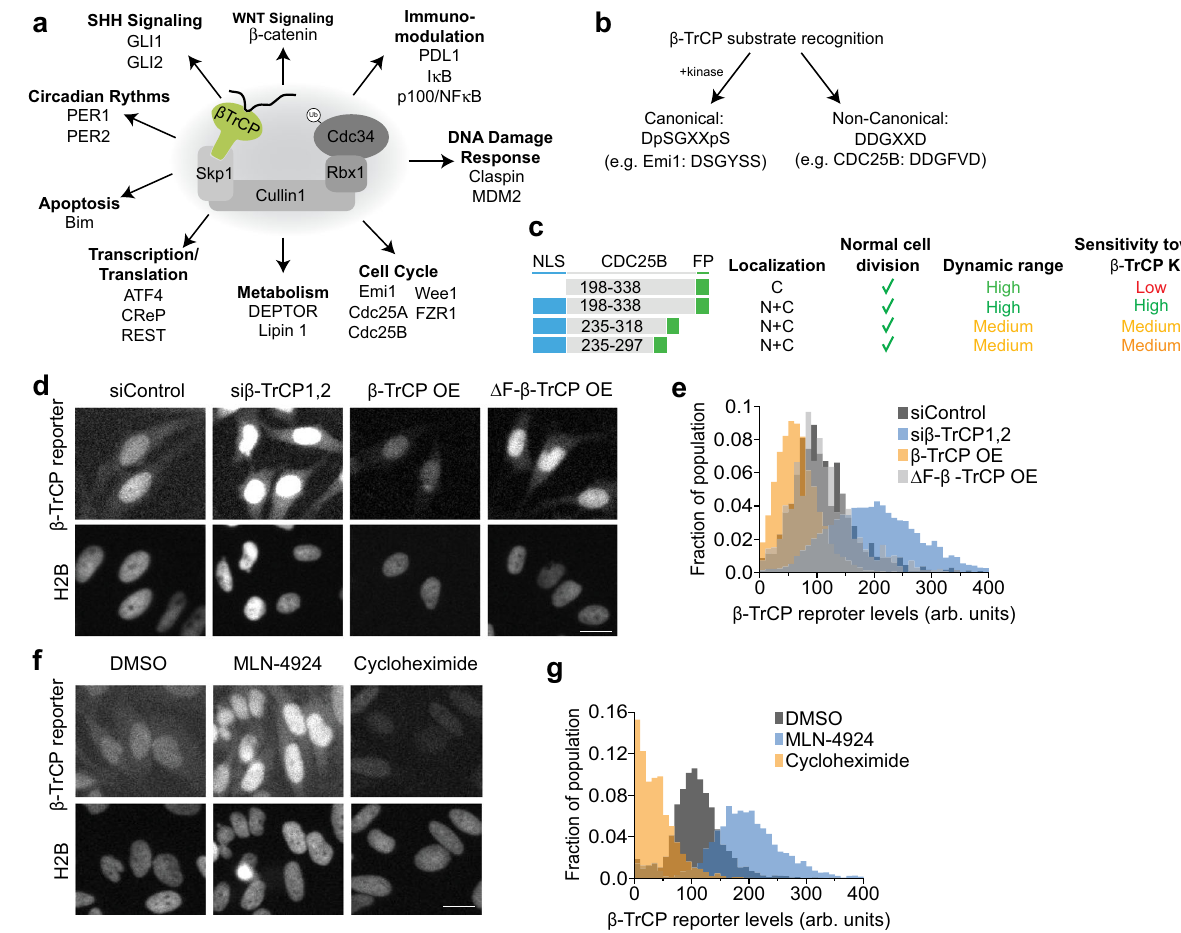
β -TrCP1,2 siRNA, transfected with full-length β -TrCP1 ( β -TrCP OE) or β -TrCP with theF-boxdeleted( Δ F- β -TrCP1OE).Imagesweretaken48haftertransfection.Scale bar is 10 μ m. Representative images from n =3 experiments. e Histograms depict- ing β -TrCP reporter levels in single cells from ( d ) N =2431 (siControl), 18,506 (si β - TrCP), 16,557 ( β -TrCP OE), and 1380 ( Δ F- β -TrCP1 OE) cells. f HeLa cells expressing the β -TrCP reporter and H2B-mTurquoise to visualize the nucleus. Cells were treated with MLN-4924 (3 μ M), cycloheximide (100 μ g/mL), NCS (200ng/mL), or DMSO for 4h before capturing the image. Scale bar is 10 μ m. Representative ima- gesfrom n =3experiments. g Histogramsdepicting β -TrCPreporterlevelsinsingle cells from ( f ) N =8180 (DMSO), 6749 (MLN-4924), 9118 (Cycloheximide) cells. Source data for all fi gure panels are provided as a Source Data fi